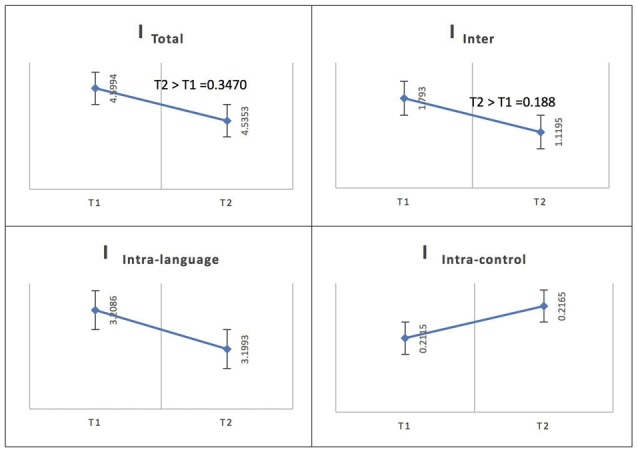
Probability value of the network integration differences across phases for L1 (Spanish) in the Spanish-speaking group. I = integration, ITotal = total integration value, IIntra_Language = Intra-integration of language areas, IIntra_Control = Intra-integration of cognitive control areas and IInter = integration between the two networks (language processing and cognitive control). A probability greater than 0.9 is considered significant.